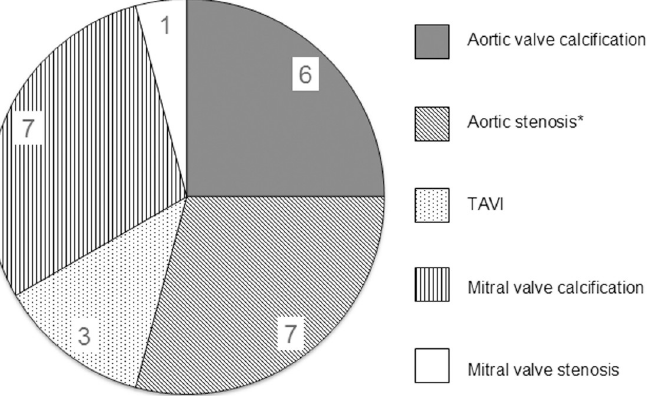
Fig 2. Types of left heart valve pathologies detected by echocardiography. Types of left heart valve pathologies detected by echocardiography in patients with CRAO. More than one pathology per patient is possible. � Two patients had high grade aortic stenosis (aortic valve area < 1.0 cm 2 ).